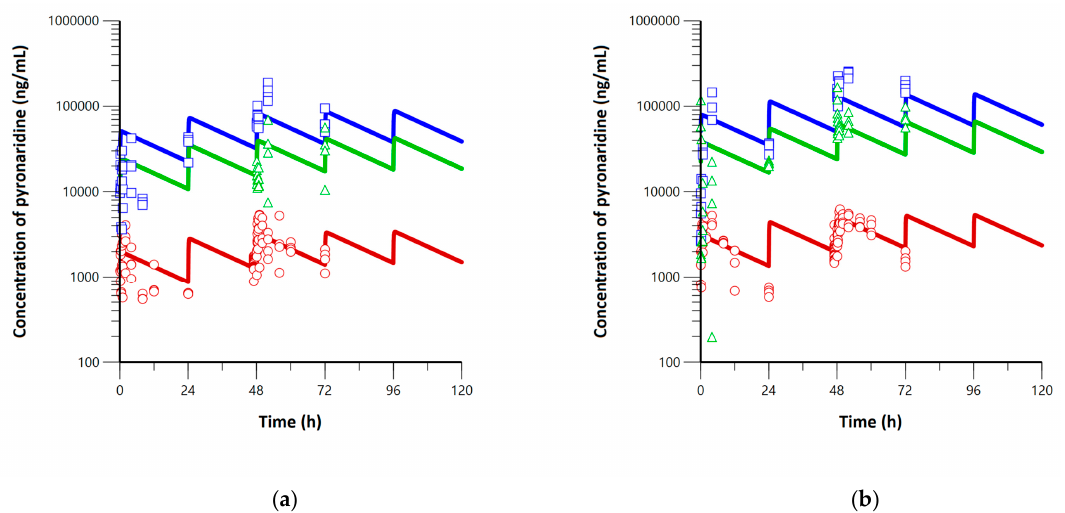
Figure 6. Simulated PK profiles for daily oral dosing of pyronaridine with ( a ) low-dose (180 mg/kg) and ( b ) high-dose (360 mg/kg) for 14 days. Blue, green, and red solid lines are simulated profiles for lung, trachea, and blood, respectively. Blue squares, green triangles, and red dots represent observed concentrations for lung, trachea, and blood, respectively.